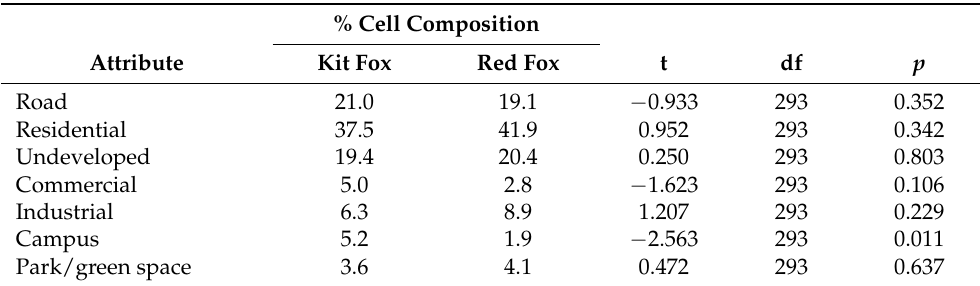
Table 6. Comparison of mean habitat attribute values between cells used by San Joaquin kit foxes and red foxes in Bakersfield, California, during